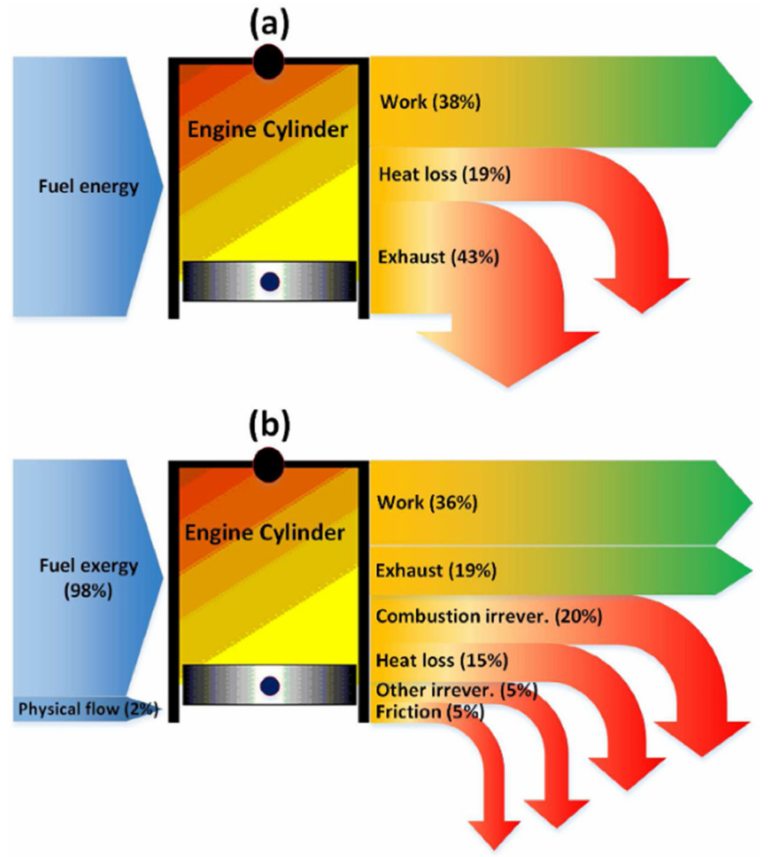
Figure 1. Schematic diagram of energy ( a ) and exergy ( b )distribution for the engine cycle